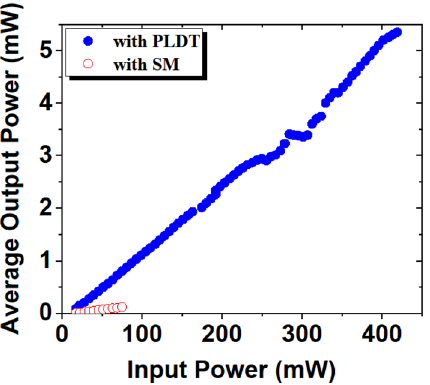
Figure 11. Measured average output power versus pump power for SAs prepared using SM (hollow red circles) and PLDT (solid blue circles).